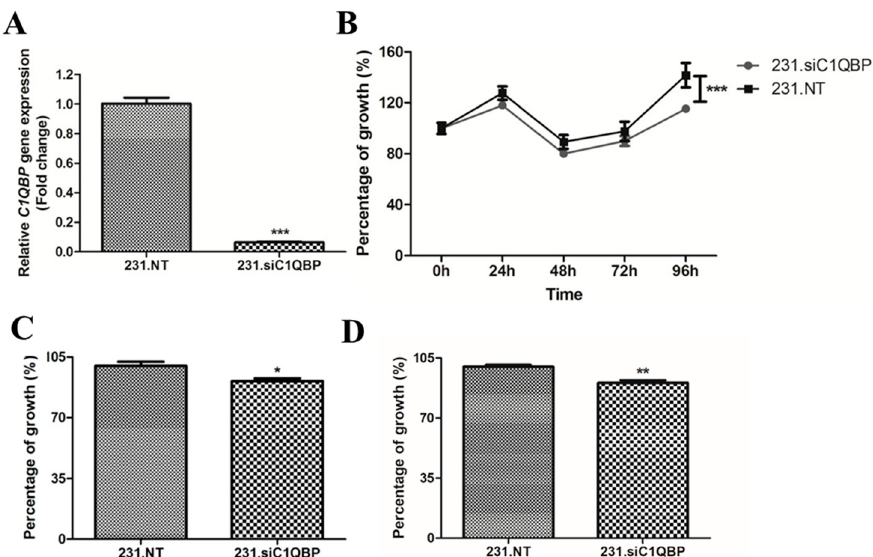
Figure 2. ( A ) C1QBP mRNA expression in knockdown and control MDA-MB-231 cells. C1QBP gene expression was decreased by 94% in cells 48 h post-transfected with C1QBP siRNA. *** p < 0.001. ( B) Downregulation of the C1QBP protein had a profound negative effect on cell growth as analysed by two-way ANOVA (*** p < 0.001). MTS assay showed that knockdown of C1QBP decreased cell proliferation at ( C ) 72 h and ( D) 96 h after transfection. * p <0.05, ** p <0.01.